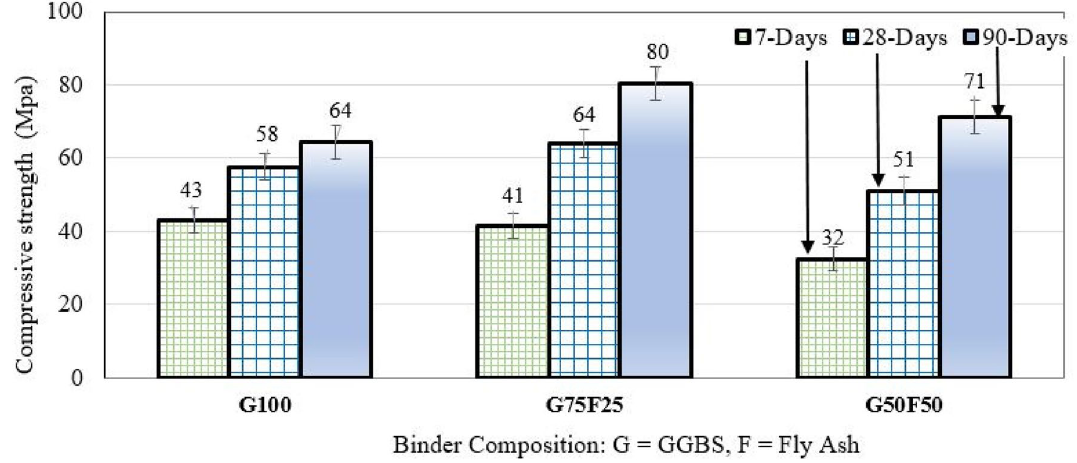
Figure 2. Strength development of G100, G75F25, and G50F50 mortar samples. Data represent the average values for NaOH molarities of 10M, 12M, 14M, and 16M, across activation ratios Na 2 SiO 3 /NaOH = 1.5, 2,